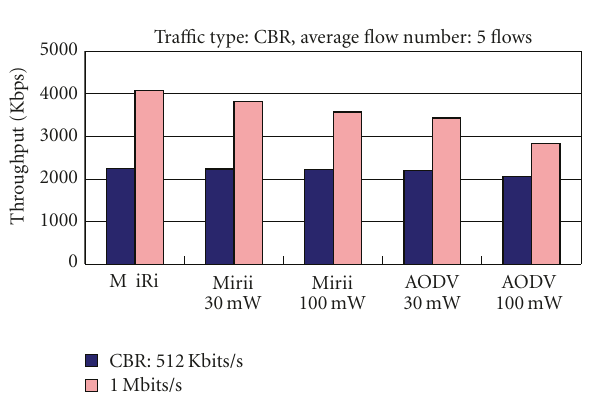
Figure 8: Throughput of di ff erent tra ffi c load in a random network